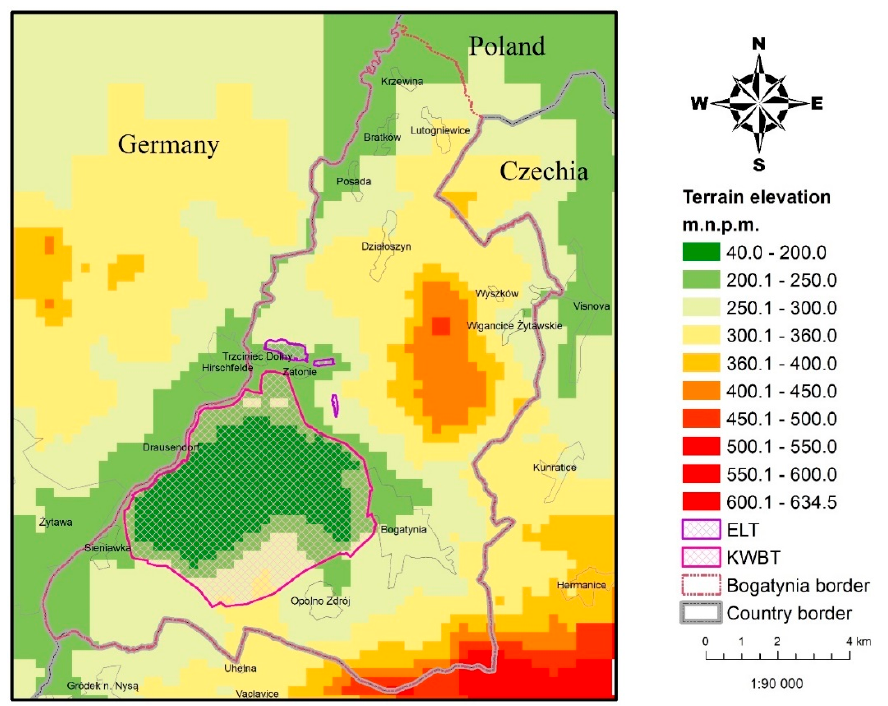
Figure 1. Natural topography in Bogatynia area (source: own study).